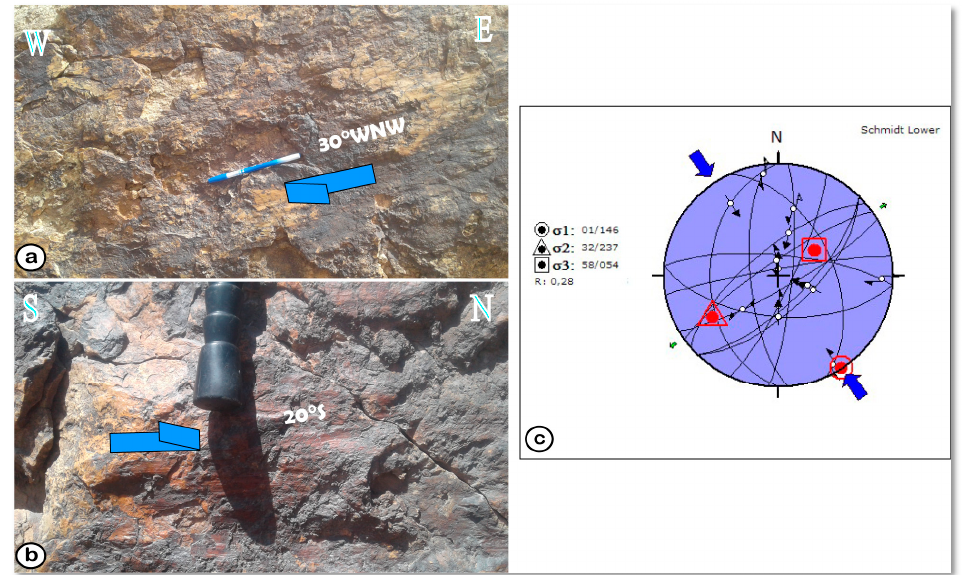
Figure 9. ( a , b ) Field photos show, respectively, a E-W dextral and N-S sinistral strike-slip faults; ( c ) stereographic projection and stress axes during the NW-SE compression. • The N-S to NW-SE extensional tectonic and the collapse of the Imiter fault ( Dt ) During this deformative phase, the NE-SW faults were reactivated as normal faults and N-S faults were reactivated as dextral strike-slip faults with a normal component (Fig- ure 10). This configuration is compatible with a stress field where the σ 1 axis is sub-verti- cal and oriented N047°-68° NE, the σ 2 axis is N051°-22° SW and the σ 3 axis is N140°-01° SE (Figure 10d,e). The R ratio = 0.38. So σ 2 ≈ ( σ 1 + σ 3)/2. Meanwhile, the ENE-WSW to E-W oriented faults (including great Imiter and related faults) showed normal offset. This is compatible with a stress field with the σ 3 axis ori- ented at N003°-08° N, the σ 2 axis at N078°-48° W and the σ 1 axis at N094°-40° E (Figure 10e). R ratio = 0.85, which means that the value of σ 2 is close to σ 1. Since the σ 1 and σ 2 axes dip at 40° and 48°, respectively, the normal offset of the Imiter fault is associated with apparent collapse. The value of the R ratio also means that normal faults can be associated with extensional strike-slip faults (associated with a transtensional tectonic setting).